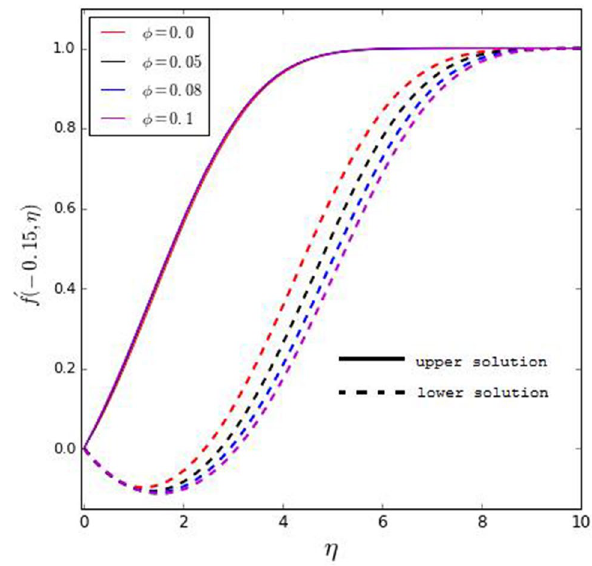
Fig. 8 Profiles for f � (− 0.1, 𝜂 ) for different 𝜙 = 0.05 for buoyancy opposing flow ( 𝜆 < 0 ) for fixed Pr = 6.7